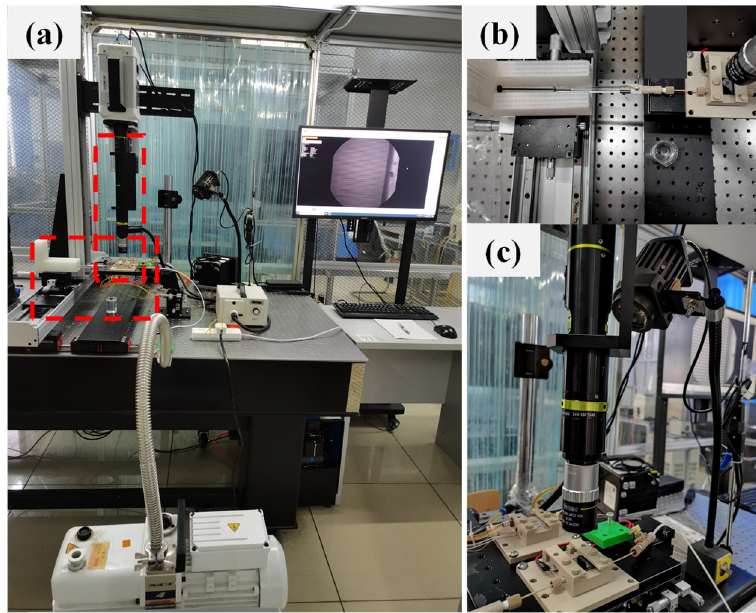
Figure 2. Diagram of experimental setup. ( a ) Capillary suction experimental platform; ( b ) Partial magnified view of filling module; and ( c ) Partial magnified view of visualization module.